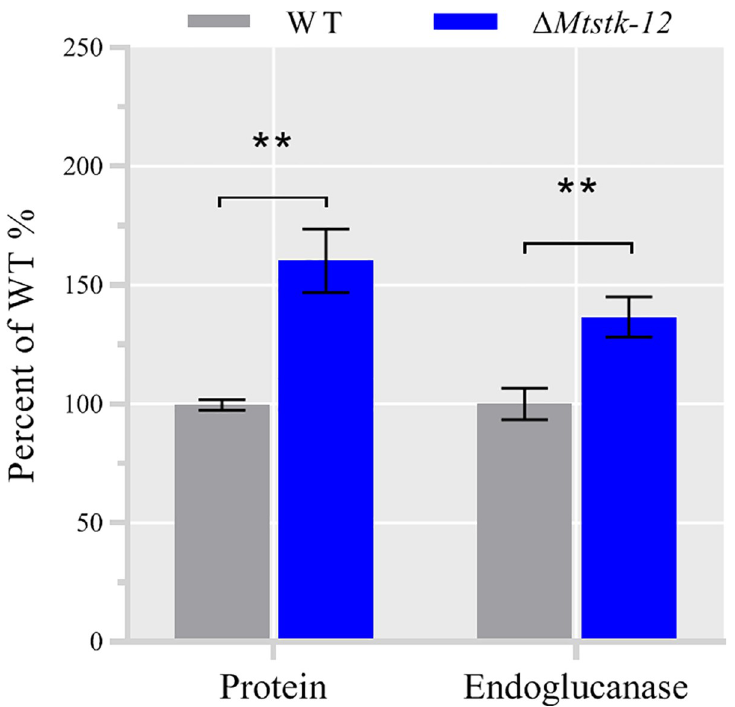
Fig 12. The M . thermophila Mtstk-12 deletion mutant shows a hyper-production phenotype under cellulolytic conditions. Avicel broth cultures were inoculated with conidia and grown for 5 days. Total extracellular protein concentration and endoglucanase activity of culture broth were measured and are expressed as a percentage of those in WT. Values represent means of at least three biological replicates, error bars show standard deviation. Statistical significance was determined by two-tailed Student’s t-test ( �� , P <